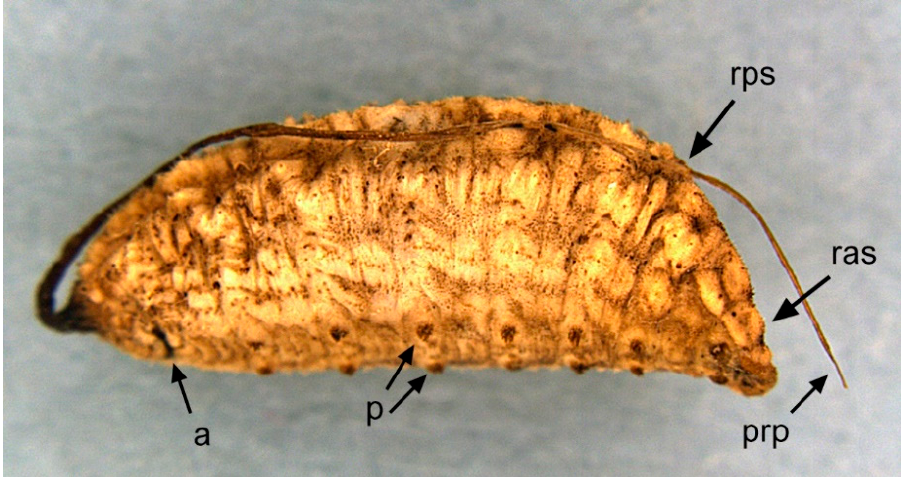
Figure 3. Meromacrus cactorum sp. nov., puparium, lateral view. Legend: a, anus; ras, region of the anterior spiracle plate; rps, region of the pupal spiracle plate; p, prolegs; prp, posterior respiratory process.